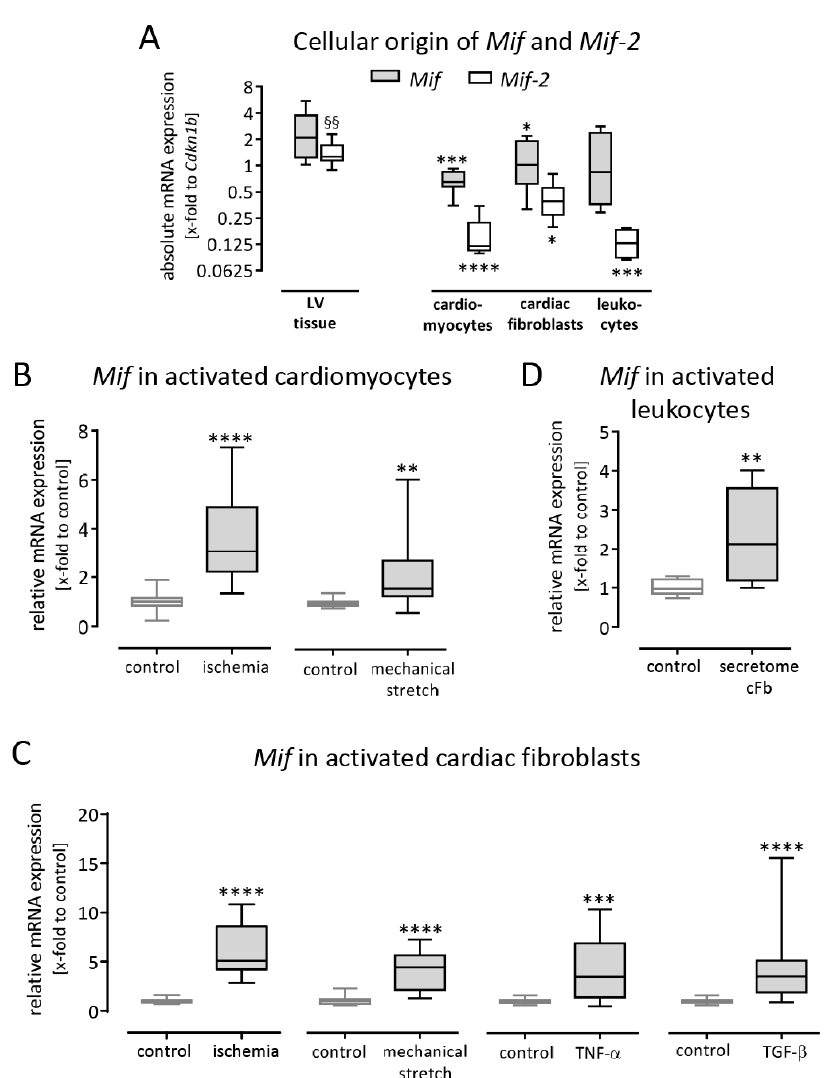
Figure 3. Mif is expressed in cardiac cells and upregulated after activation. ( A ) Basal gene expression of Mif and Mif-2 was determined in LV tissue and individual cell cultures. Cardiac fibroblasts and leukocytes exhibited similar Mif expression compared with LV tissue, whereas cardiomyocytes expressed significantly less Mif . While Mif and Mif-2 revealed similar expression levels in the LV tissue, considerably less Mif-2 was determined in the investigated cardiac cell types representing not the main source of cardiac Mif-2 . ( B ) Cultured cardiomyocytes were activated by simulated ischemia for 24 h (D-glucose was replaced by L-glucose and oxygen was reduced to 1%) or mechanically stretched with 10% elongation at a frequency of 1 Hz for 6 h. Ischemia as well as mechanical stretch induced Mif gene expression in cardiomyocytes. ( C ) Cardiac fibroblasts were exposed to simulated ischemia for 24 h or to mechanical stretch (10% elongation, 1 Hz) for 6 h. Both external stimuli resulted in increased Mif expression. Moreover, cardiac fibroblasts were stimulated with 10 ng/mL TNF- α or 5 ng/mL TGF- β for 6 h which led to increased gene expression levels of Mif . ( D ) Leukocytes were activated with cell culture supernatant derived from cardiac fibroblasts exposed to simulated ischemia. This conditioned medium induced the gene expression of Mif in leukocytes after 24 h. Basal gene expression levels are shown as absolute mRNA expression (x-fold to the housekeeping gene Cdkn1b ) using the formula 2 − ∆ Ct and presented in box plots (min to max). Alteration of gene expression is depicted as relative mRNA expression (x-fold to control cells) using the formula 2 − ∆∆ Ct . Gene expression data represent 2–8 independent experiments, each performed in 4–8 replicates. * significantly different compared with LV tissue or untreated cells as control; * p < 0.05; ** p < 0.01; *** p < 0.001; **** p < 0.0001. § significantly different compared with Mif expression in LV tissue; §§ p < 0.01.